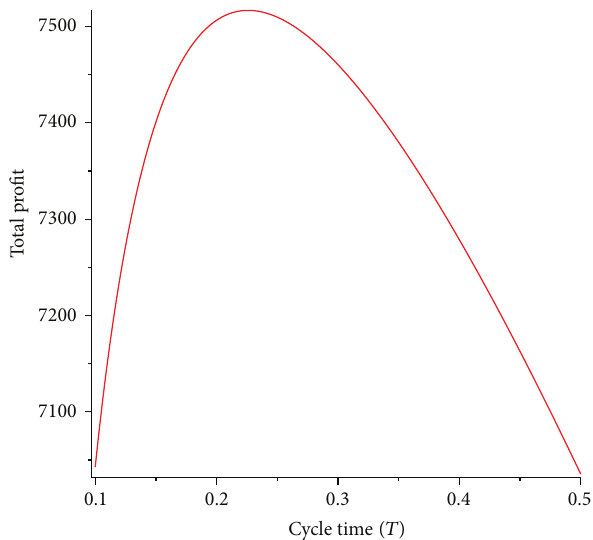
Figure 3: Concavity of total profit with respect to cycle time 𝑇 for 𝑀 < 𝑁 .